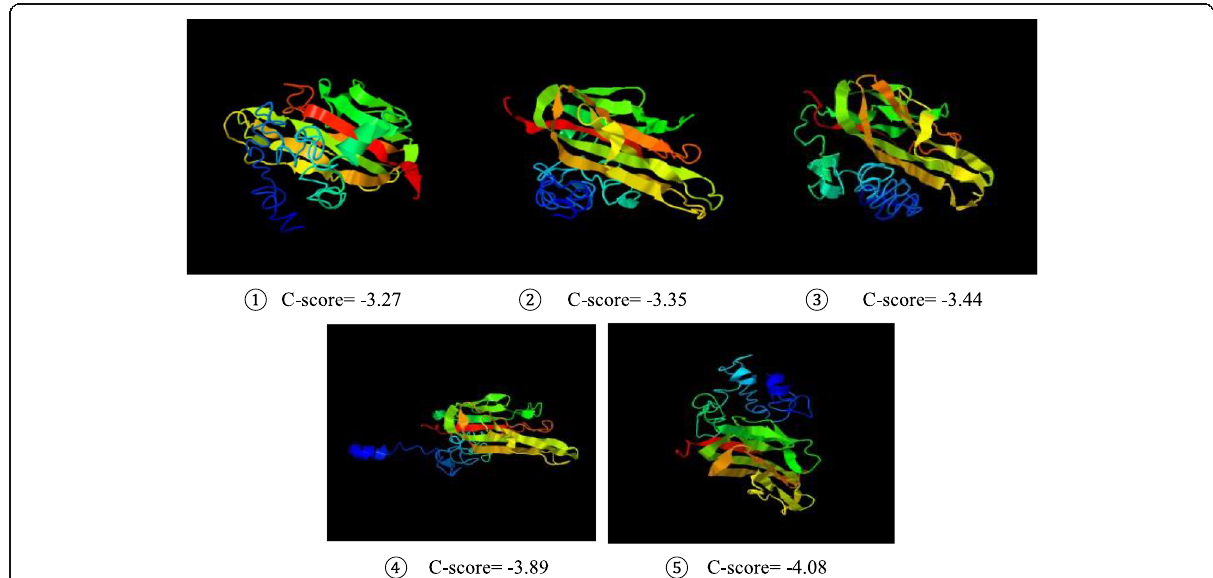
Fig. 5 Top 5 final models predicted by I-TASSER ① model 1, ② model 2, ③ model 3, ④ model 4, and ⑤ model 5